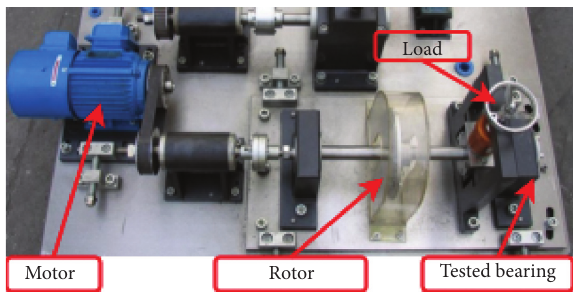
Figure 17: Bearing fault simulation experimental device.